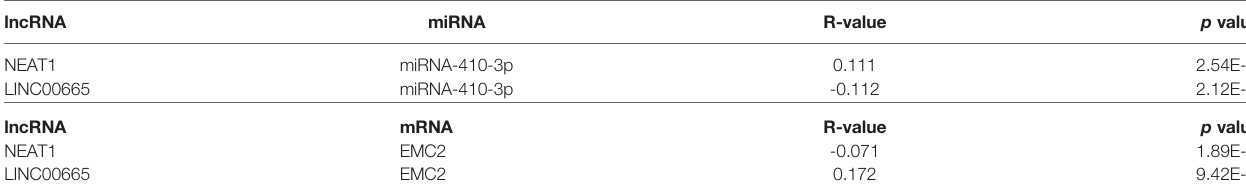
TABLE 1 | Correlation analysis between lncRNA and miRNA-410-3p or lncRNA and EMC2 in BRCA determined by starBase database. lncRNA